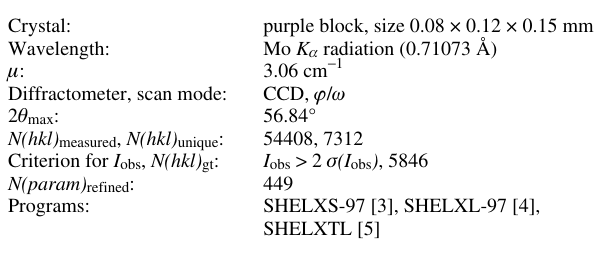
Table 1. Data collection and